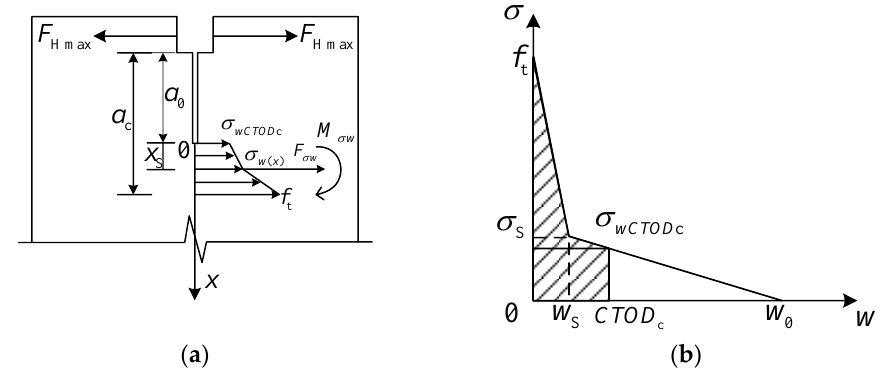
Figure 5. Case 2: ( a ) cohesive stress distribution; ( b ) softening curve.